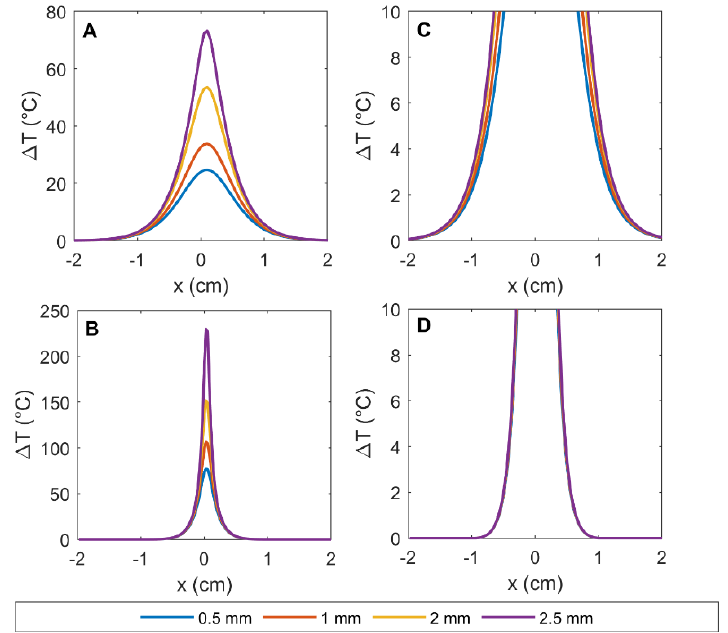
Figure 9. Temperature distribution along the x − axis within the tumor at 4 different points with the distance of 0.5, 1, 2, and 2.5 mm from the tip of the source and placed in the direction of laser beam and at 30 s after irradiation at P = 2.1 W, for ( A ) pancreas and ( B ) pancreas loaded with 12.5 µg/mL GNR s. A zoom of the curves in the ΔT range 0– 10 °C is reported for ( C ) pancreas and ( D ) pancreas loaded with 12.5 µg/mL GNRs.